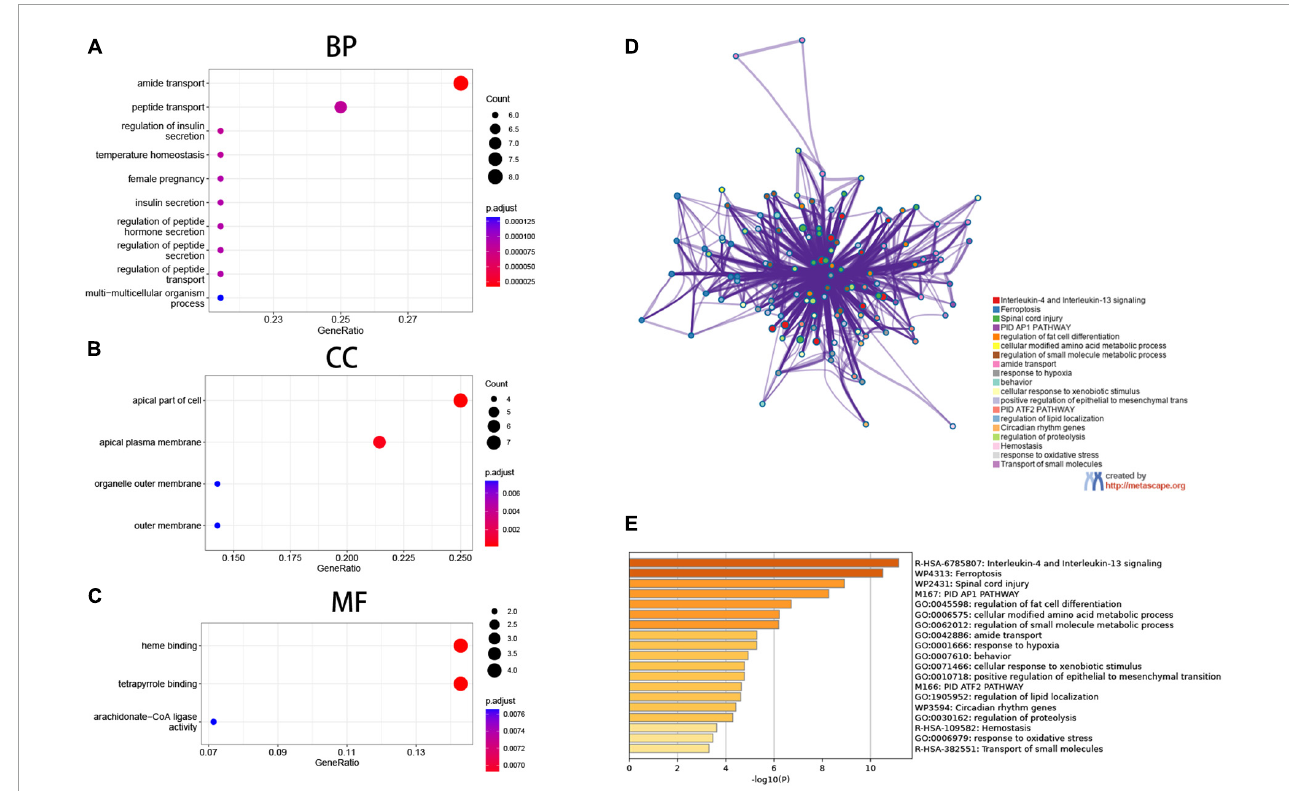
FIGURE3 Functional enrichment analysis. (A–C) Gene Ontology (GO) enrichment analysis, (A) biological process (BP), (B) cellular components (CC), (C) molecular function (MF). (D,E) Matascape gene enrichment analysis IL-1 and IL-13 signaling pathways is most notable.